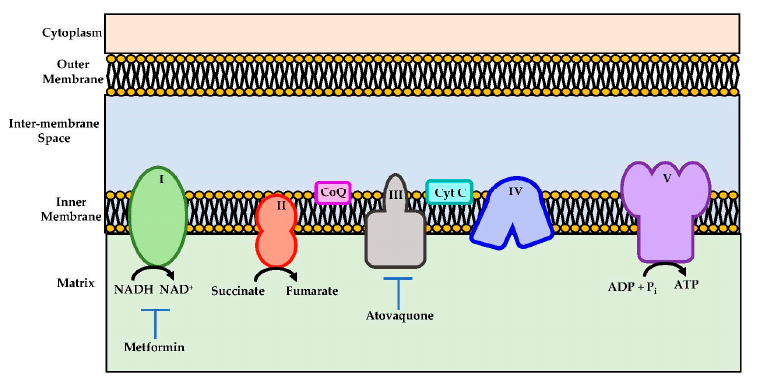
Figure 2. Schematic representations of mitochondrial electron transport chain. Metformin and atovaquone inhibits Complex I and complex III respectively and they are indicated as potential therapeutics importance.